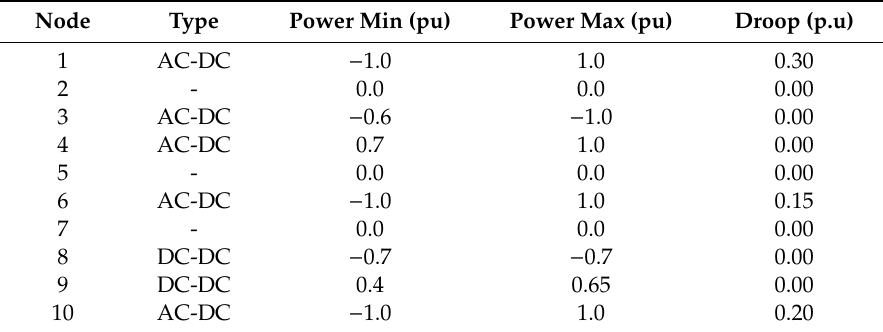
Table 3. MVDC network converter